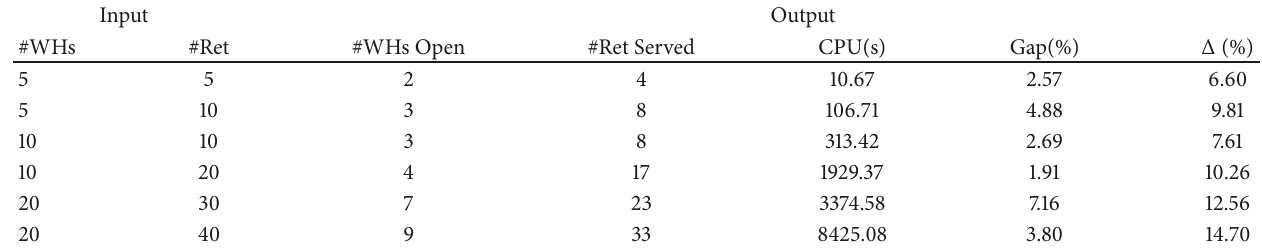
Table 5: The computational results for P with medium capacity.